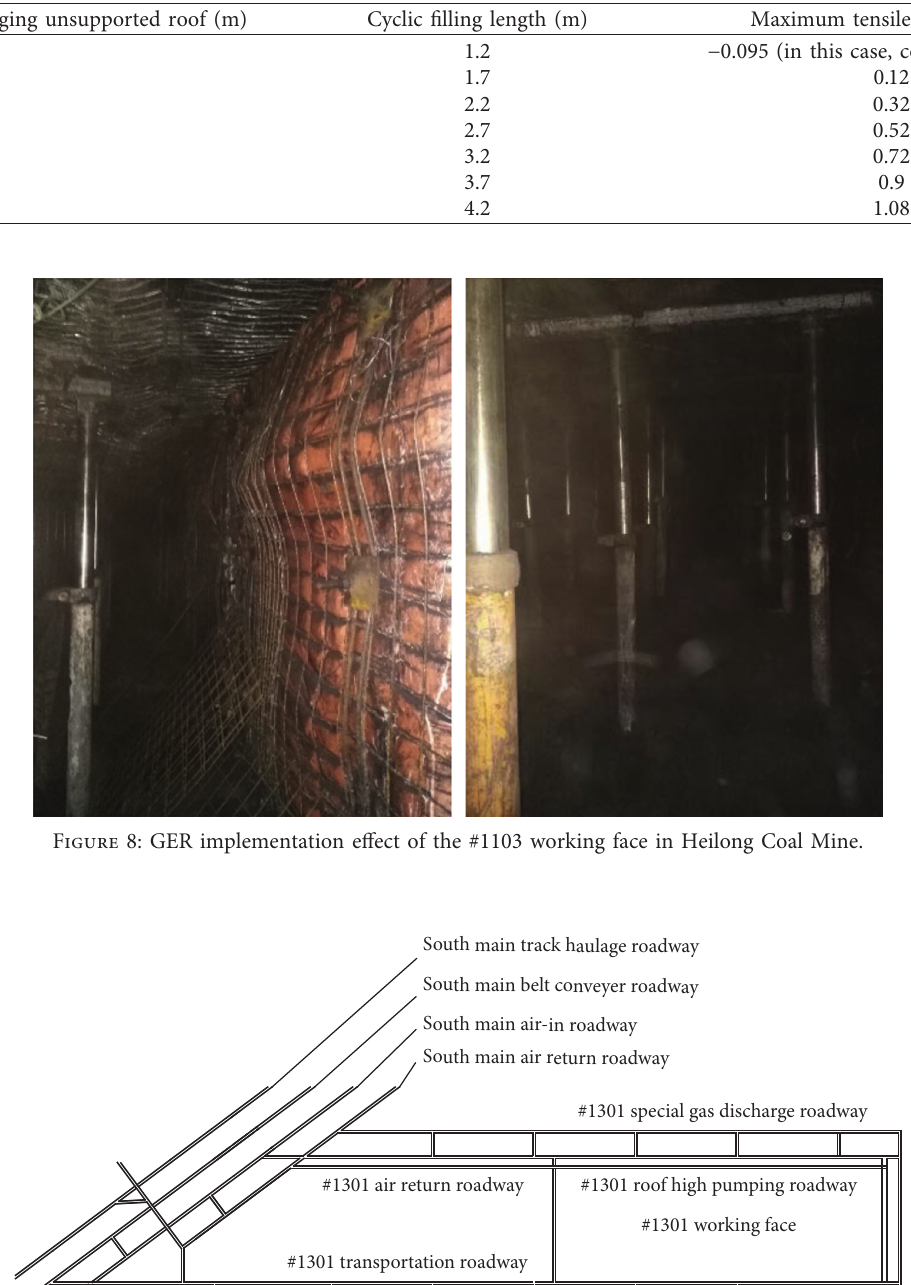
Table 1: Maximum tensile stress of the lower immediate roof in GER-RF with respect to the length of the lagging unsupported roof and cyclic filling length.